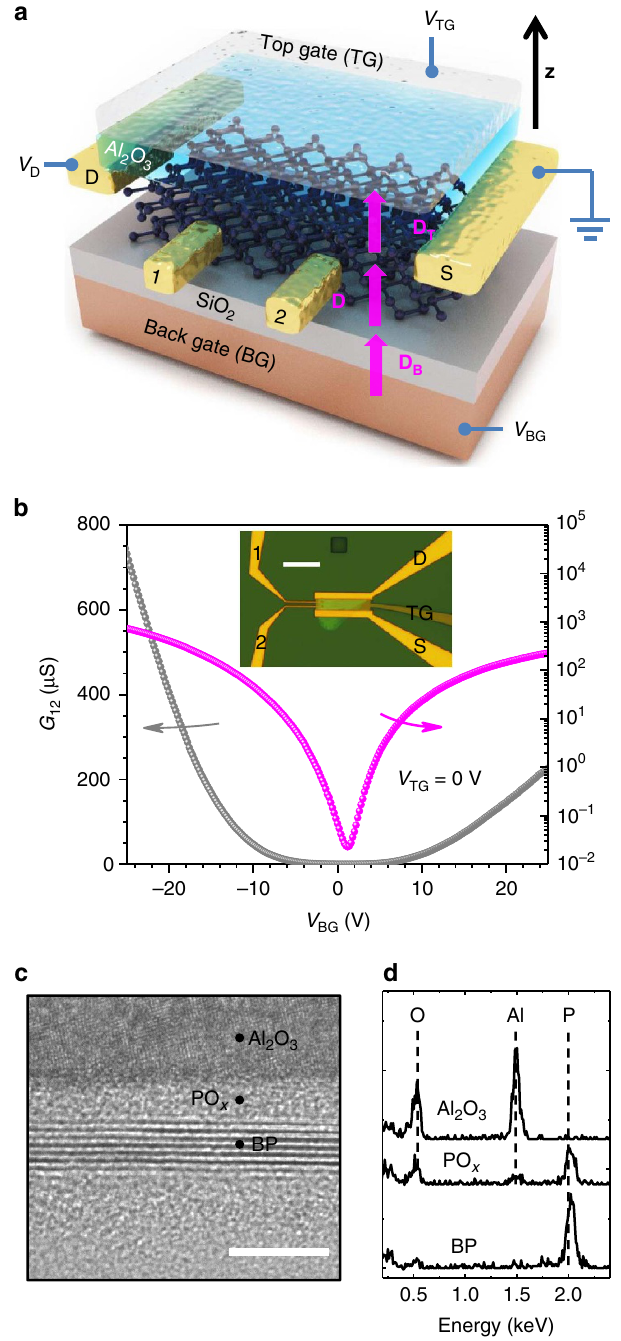
Figure 1 | Experimental scheme for BP bandgap tuning. ( a ) The schematic view of the dual-gate BP thin-film transistor for the realization of bandgap tuning. ( b ) The 4nm-thick BP film conductance in linear (left axis) and logarithmic (right axis) scales as a function of the back gate bias ( V BG ) at zero top gate bias ( V TG ¼ 0V). The conductance G 12 is measured using a four-probe scheme as shown in a , to eliminate the effects of the contact resistance. Inset: an optical image of a typical dual-gate BP transistor. Scale bar, 10 m m. ( c ) High-resolution cross-section transmission electron micrograph showing the BP layer, which is about 4nm thick. The PO x layer between the BP layer and Al 2 O 3 is 2–3nm thick. Scale bar, 8nm. ( d ) Energy dispersive X-ray spectra from three selected spots in c .